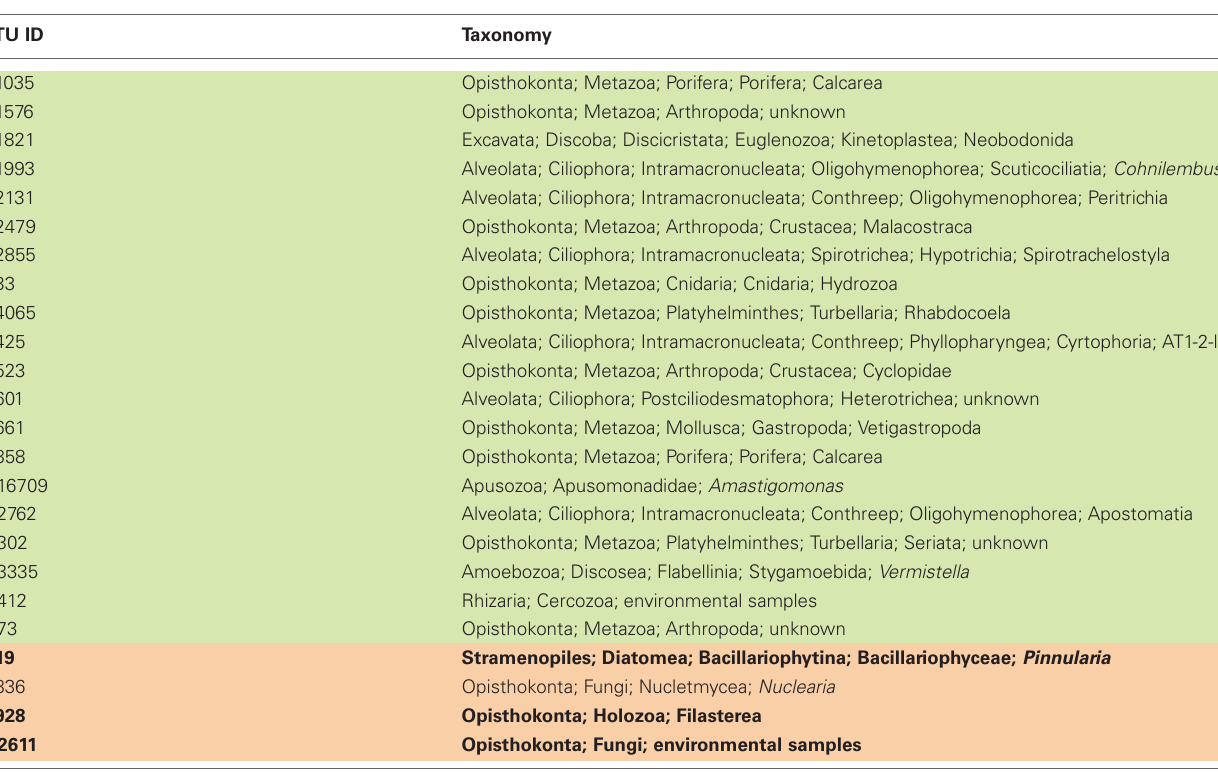
Table A4 | Taxonomy for OTUs listed in Figure 7.